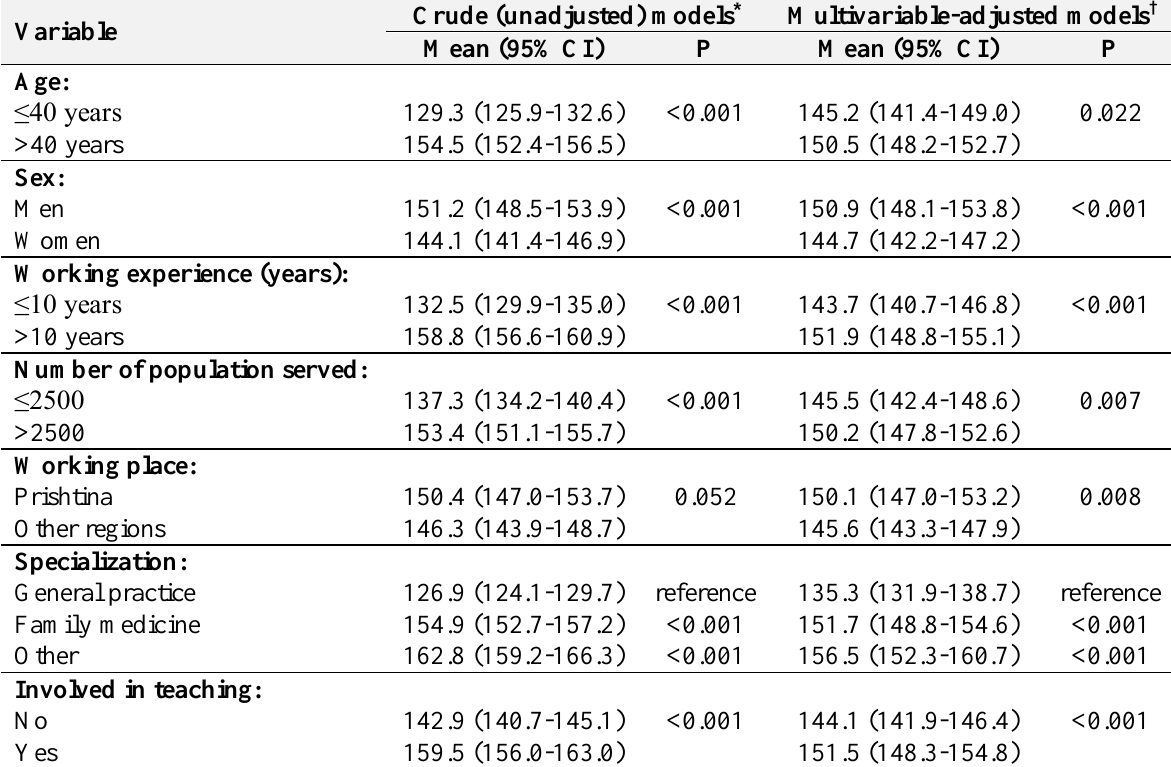
Table 4. Association of self-assessed competencies with demographic characteristics, work experience and specialization of primary health care physicians in